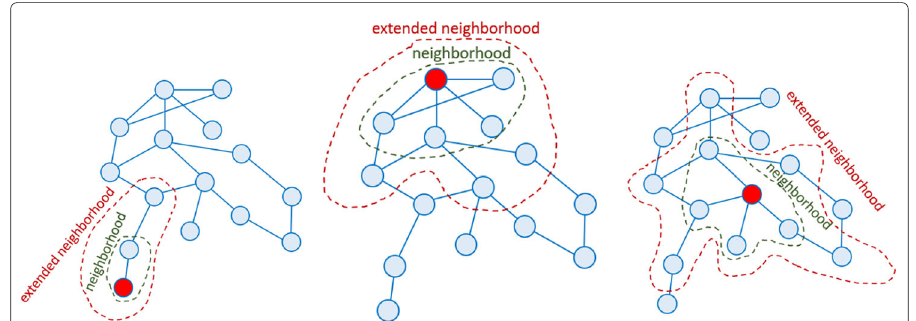
Fig. 6 The neighborhoods and extended neighborhoods of three red highlighted nodes in a toy network. LinkAUC assesses node ranks by their ability to predict which nodes are in each other’s neighborhoods, whereas HopAUC performs the same assessment for the extended